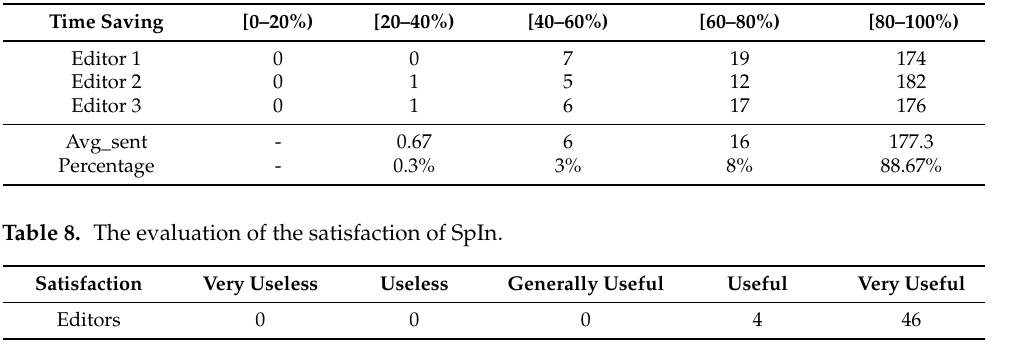
Table 7. Time-saving assessment. There are 200 total sentences. Each interval represents the number of sentences that save the corresponding time of each editor. Avg_sent indicates the average sentences located in each interval. The percentage represents the fraction of sentences that save the corresponding time.